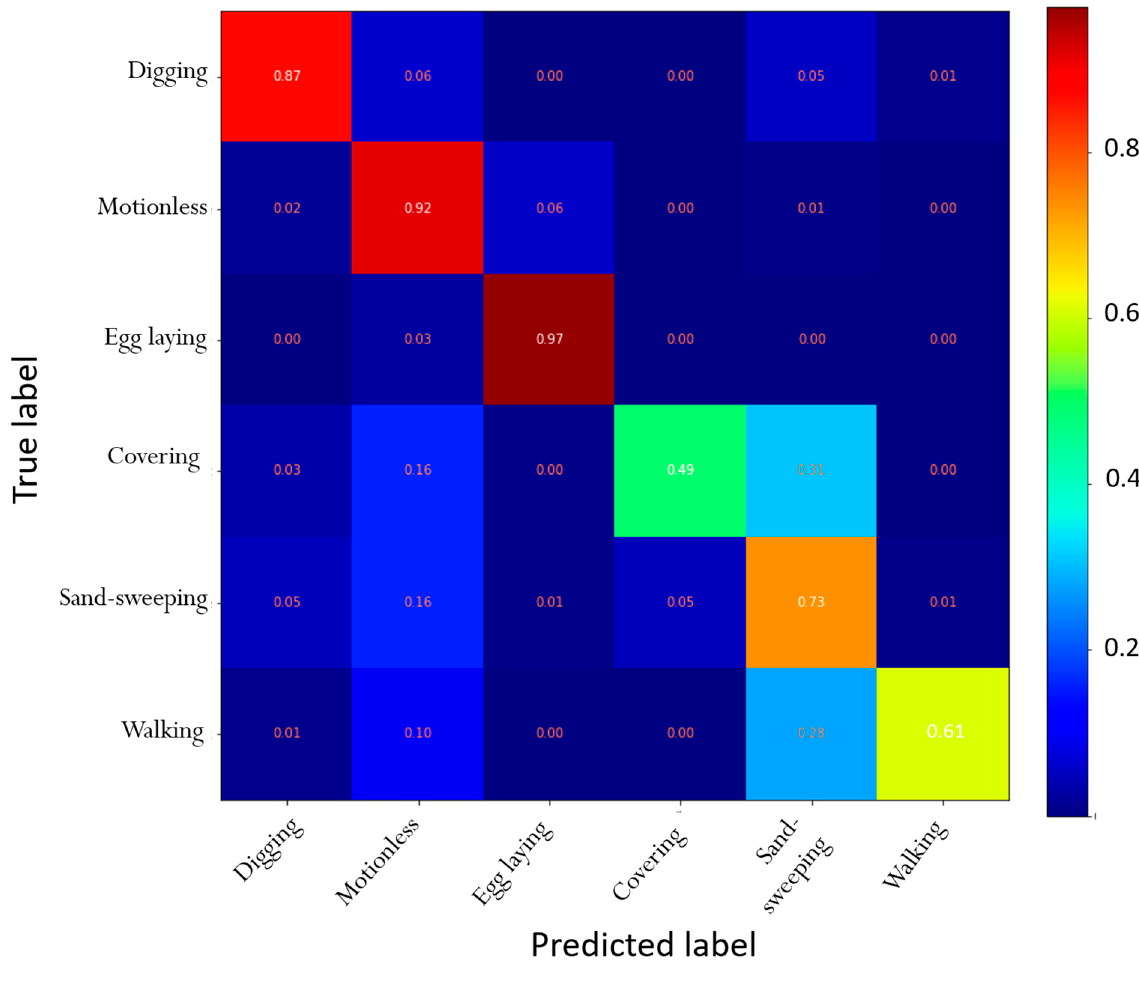
Figure 5. Confusion matrix of the predictions obtained from the V-net for the three green turtles of the validation dataset. Table 2. Recall and Precision index obtained for the six nesting behaviors from the V-net for the three green turtles of the validation dataset. Accuracy (in bold) measures the ability of the V-net to correctly identify all behaviors as a whole.